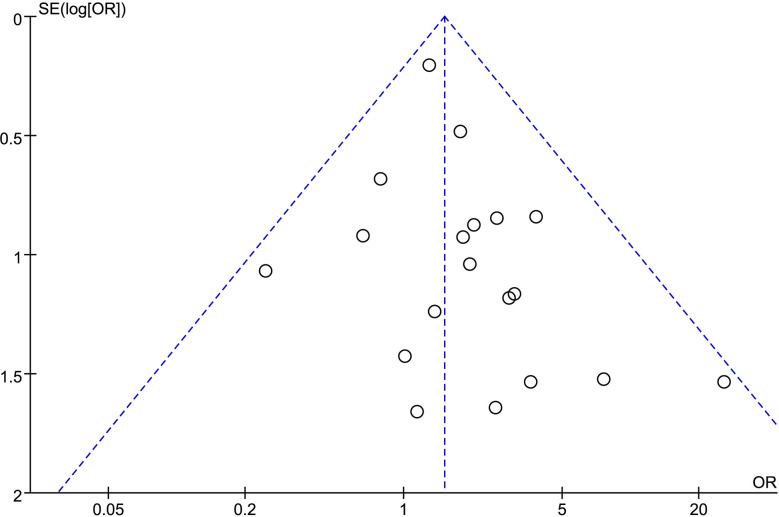
Funnel plot of PSM.